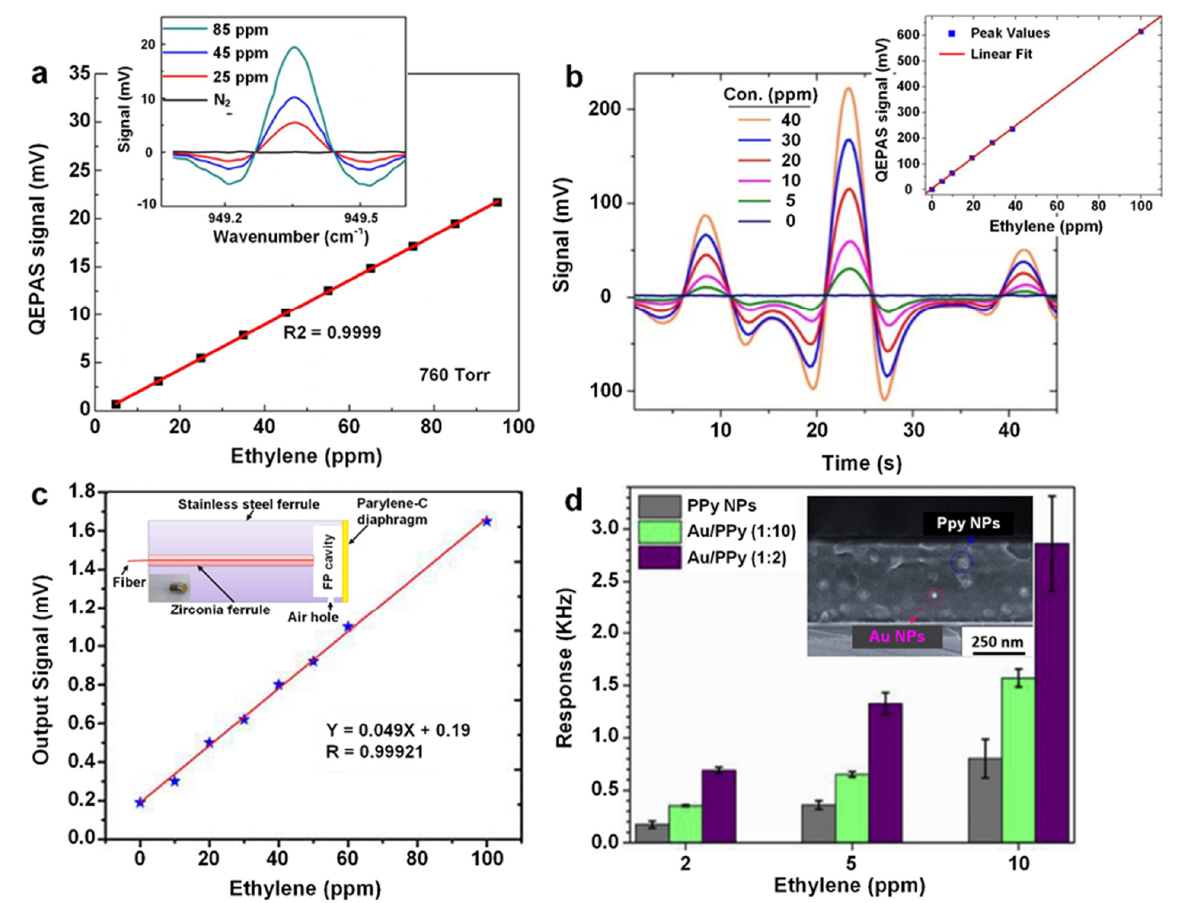
Figure 3. ( a ) Linearity of photoacoustic sensor signals (~949.3 cm −1 ) to the concentration of ethylene gas under 750 Torr. Inset: typical sensing signals of ethylene at the concentrations of 25, 45 and 85 ppm. Reproduced from Ref. [32] with permission from the Optical Society. ( b ) The corresponding signals of the ethylene gas at different concentrations. Inset: the intensity of the dominating signal peak against the concentration of ethylene gas. Reproduced from Ref. [33] with permission from the Optical Society. ( c ) The linear function of the ethylene gas-sensing signal against its concentration. Inset: the schematic and photographic image parylene-C diaphragm-designed, fiber-optic low-frequency sensor head. Reproduced from Ref. [36] with permission from Elsevier. ( d ) The response of three PPy-based L-SAW sensors to ethylene gas at concentrations of 2, 5 and 10 ppm. Inset: side-view of the spin-coated Au/PPy microstructure. Reproduced from Ref. [38] with permission from Elsevier.